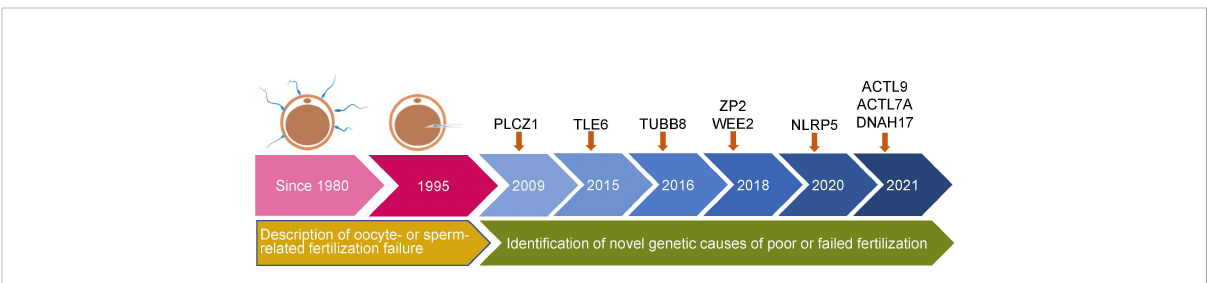
FIGURE 1 Work fl ow diagram of the literature review procedure.